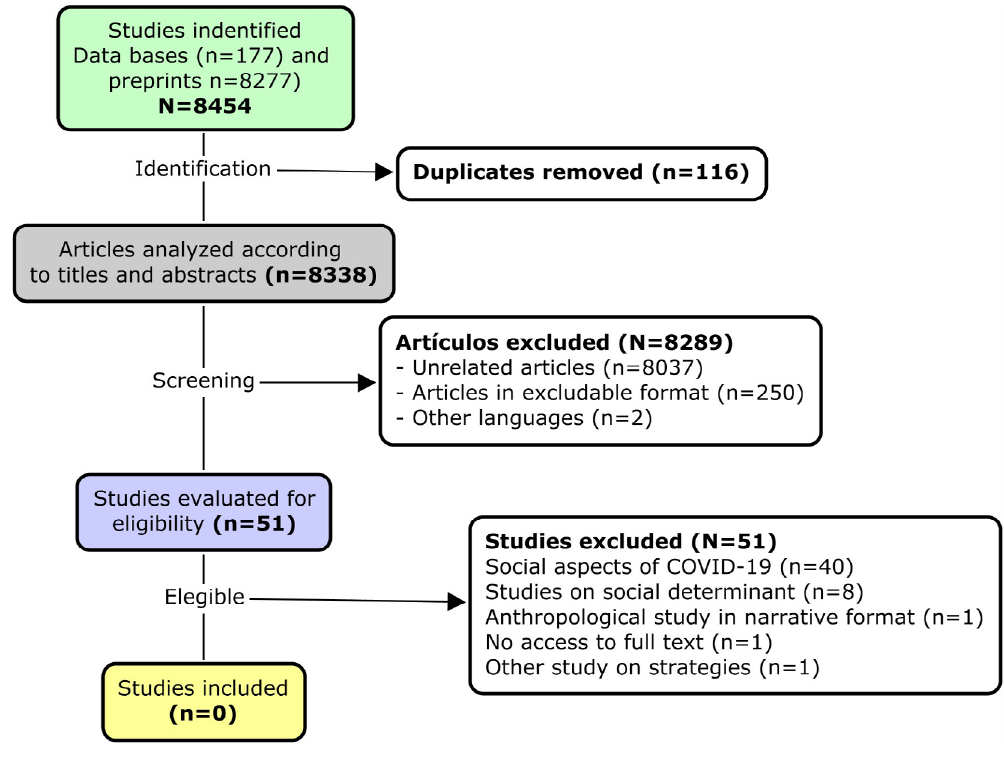
Figure 3. PRISMA flow chart for the selection of studies on stickers and memes against